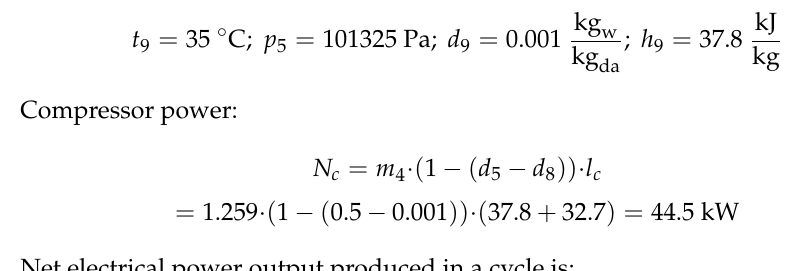
The parameters of the air at the outlet of the compressor are determined as follows: air is compressed from p 8 to p 9 with the temperature t 9 reached by removing heat during the compression by the cooling agent.